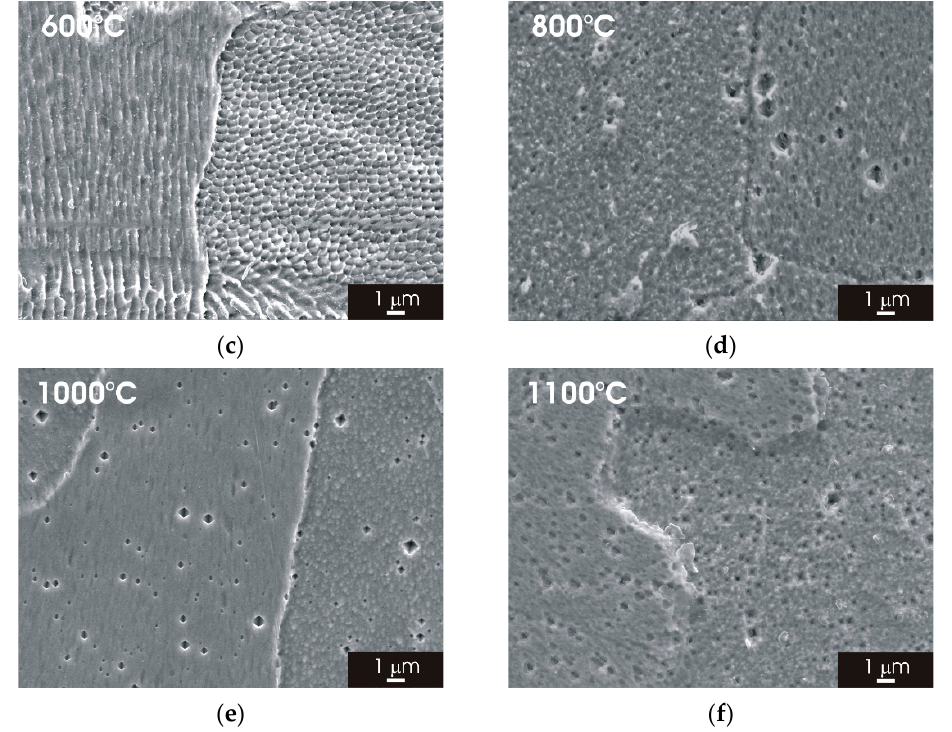
Figure 6. SEM micrographs of L-PBF-XZ 316L stainless steel after 2 h thermal treatment. ( a ) 200 °C; ( b ) 400 °C; ( c ) 600 °C; ( d ) 800 °C; ( e ) 1000 °C; ( f ) 1100 °C.